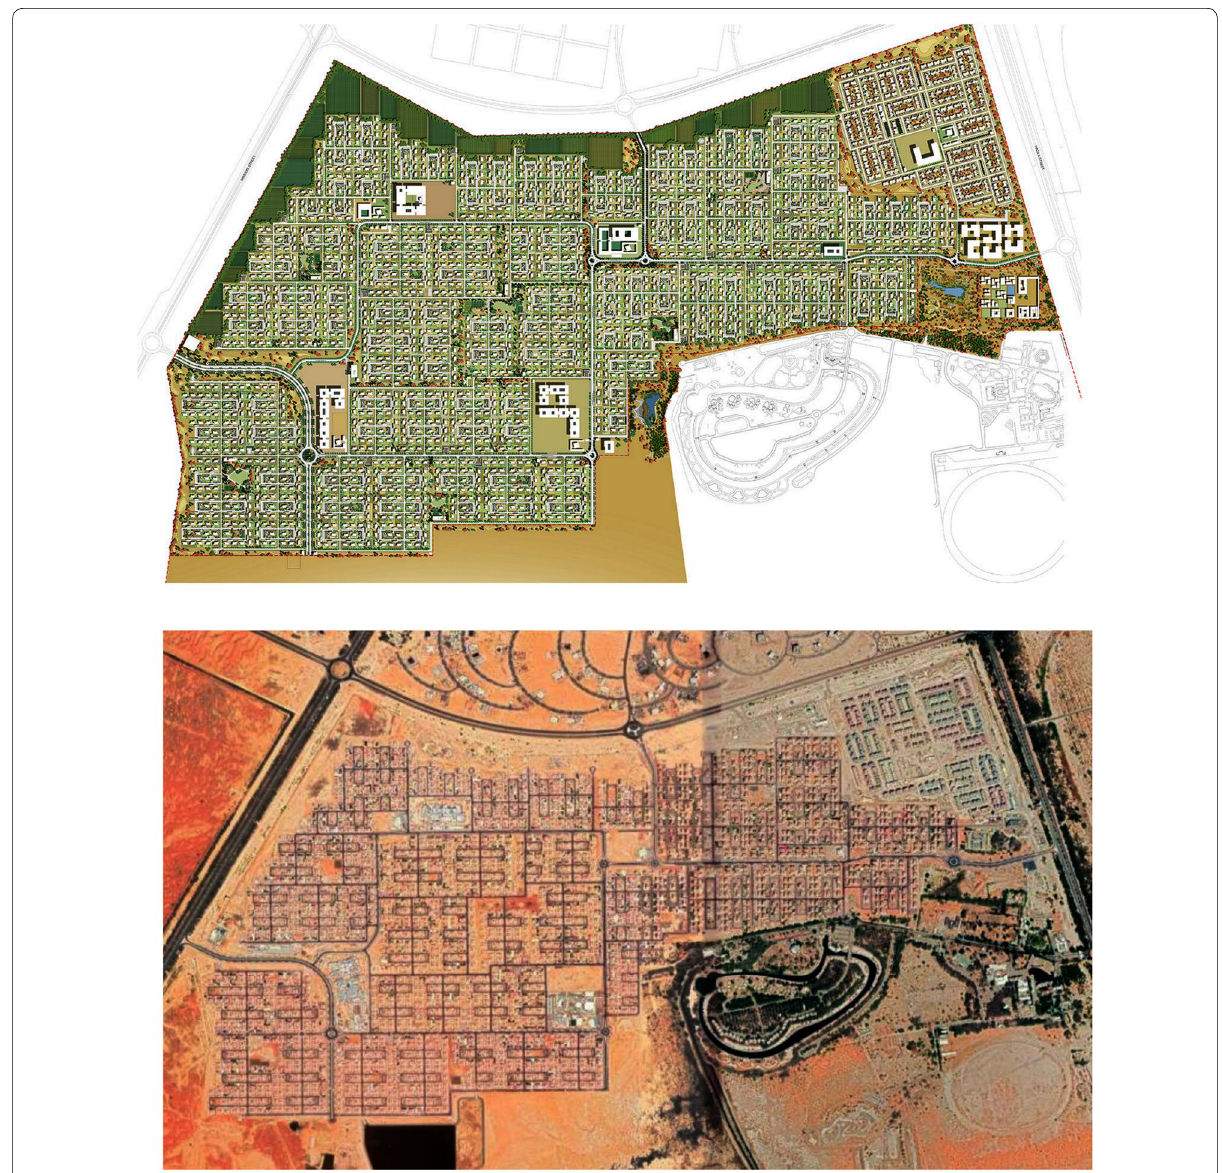
Fig. 1 A master plan depiction (on the top) (Plan Al Ain… 2015) and a picture from GoogleMaps of the implemented project (on the bottom) of Al Ain Faydah, Al Ain, Abu